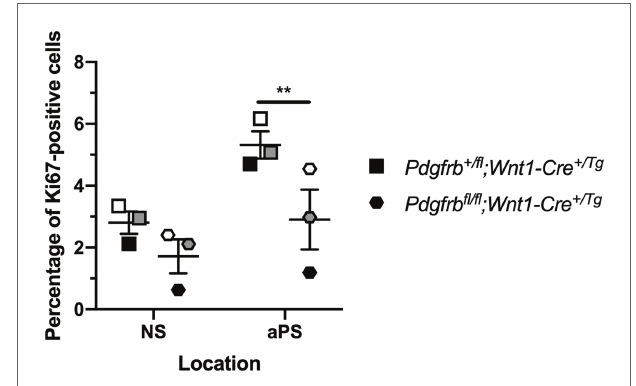
FIGURE 9 | Ablation of Pdgfrb in the NCC lineage leads to decreased proliferation in the anterior secondary palatal shelves (aPS) at E13.5. Scatter dot plot depicting the average percentage of Ki67-positive cells per embryo in the NS and aPS in Pdgfrb +/fl ; Wnt1-Cre +/Tg vs. Pdgfrb fl/fl ; Wnt1-Cre +/Tg embryos at E13.5. Data are presented as mean ± SEM. ** p < 0.01. Shades correspond to independent experiments across three biological replicates. NS, nasal septum; aPS, anterior secondary palatal